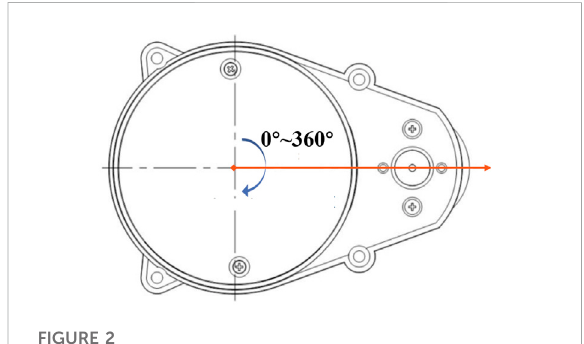
FIGURE 2 The de fi nition of the scanning angle.